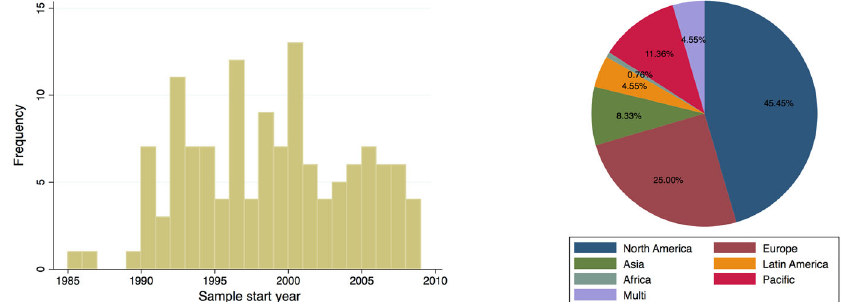
Fig. 1 Distribution of sample observations over time and over world regions. The plot in the left column shows the distribution of the sample start year of each study included in the sample. The pie graph in the right column depicts the distribution of the countries covered by the primary studies. ‘Multi’ refers to studies examining more than one